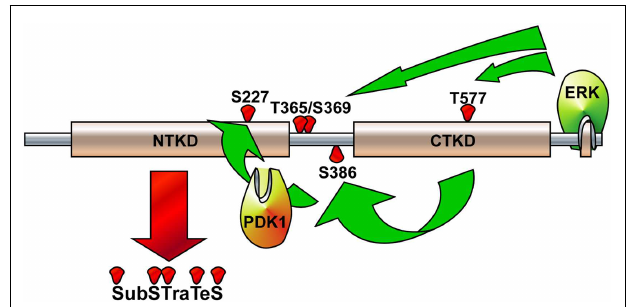
FIGURE 3 | Illustration of RSK2 activation mechanisms .The activated extracellular signal-regulated kinase (ERK) binds at the ERK docking consensus sequences in the C-terminal domain of RSK2 and phosphorylates atThr365/Ser369 in the linker domain and atThr577 in the C-terminal kinase domain (CTKD), resulting in the activation of CTKD.The activated CTKD then phosphorylates at Ser386 in the linker domain, providing a docking site for PDK1.The PDK1 phosphorylates at Ser227 in the N-terminal kinase domain (NTKD), resulting in the activation of NTKD.The activated NTKD obtains ability to phosphorylate the downstream target proteins, which include kinases, transcription factors, and epigenetic